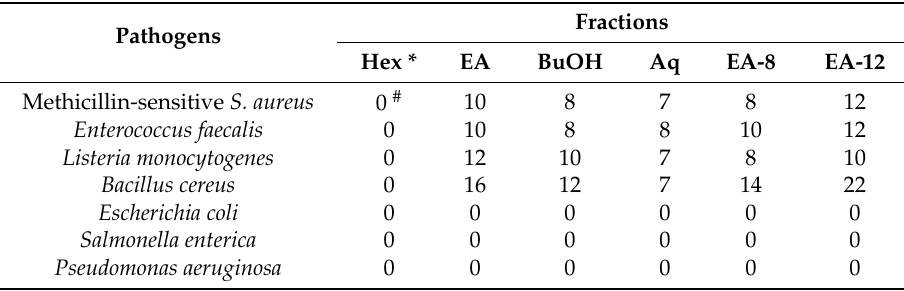
Salmonella enterica Pseudomonas aeruginosa